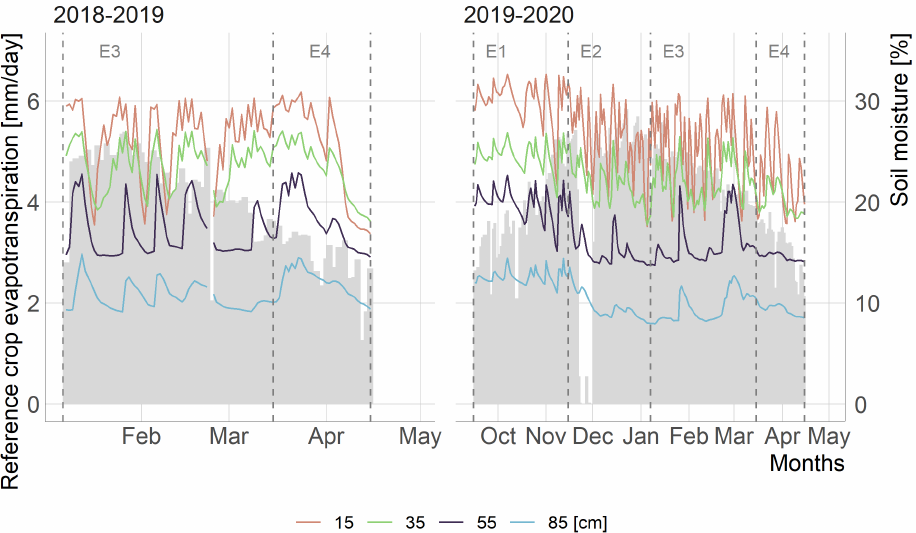
Figure 2. Variation of crop evapotranspiration and soil moisture content at different depths (15, 35, 55, and 85 cm) in the kiwi orchard for the 2018–2019 and 2019–2020 season. Horizontal lines correspond to the depths of soil moisture of the Sentek probe. Blank space between late April and early October corresponds to the period without